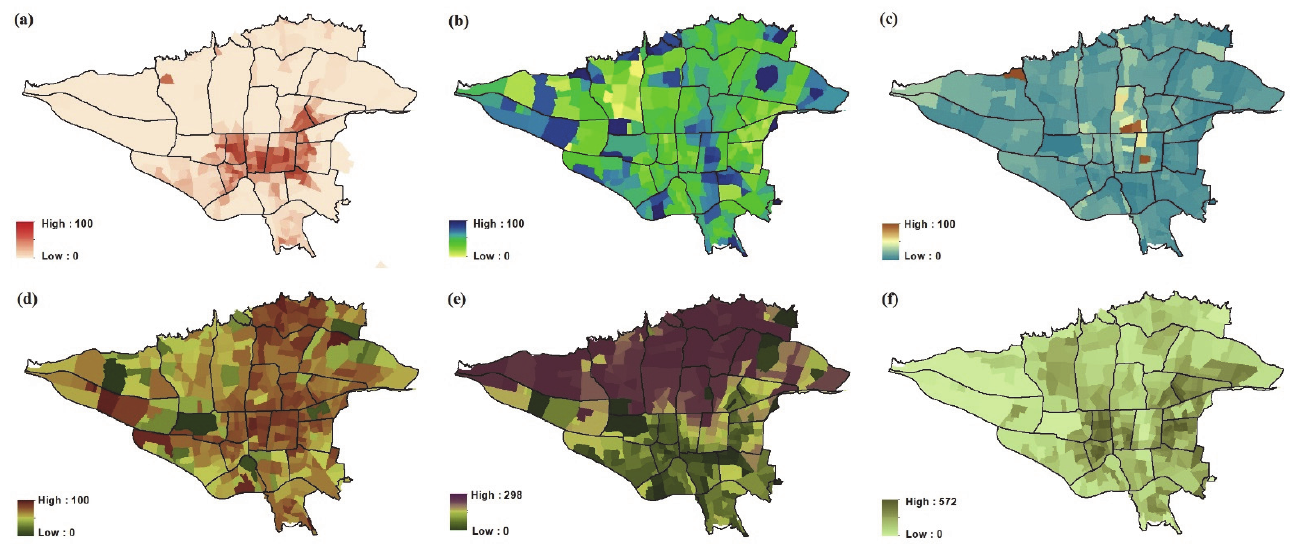
Figure 4. Spatial analysis of factors affecting water consumption in Tehran: ( a ) deteriorated area (%); ( b ) buildings over 30 years old (%); ( c ) migrants; ( d ) built-up area ratio (%); ( e ) average residential floor area; ( f ) population density.